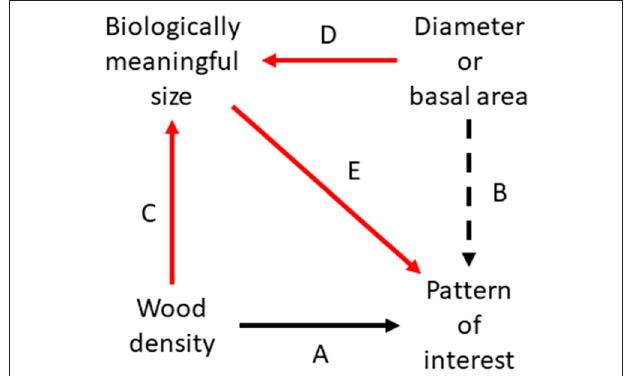
FIGURE 3 | Flow chart showing size-myopic with black (A and B) and size-conscious inference with solid arrows (A, C, D, and E). The size-myopic logic focuses on arrow A but typically takes tree size into account based on diameter or basal area (arrow B). However, wood density not only influences the pattern or process of interest but also the biologically meaningful size (arrow C) together with dimension-based measures (arrow D). A size-conscious approach focuses on impact of wood density on the pattern of interest (arrow A) by taking the biological meaningful size into account (arrow E). Analogously, in studies e.g., focusing on crown shape instead of wood density, the impact of crown shape on size (arrow C) should be